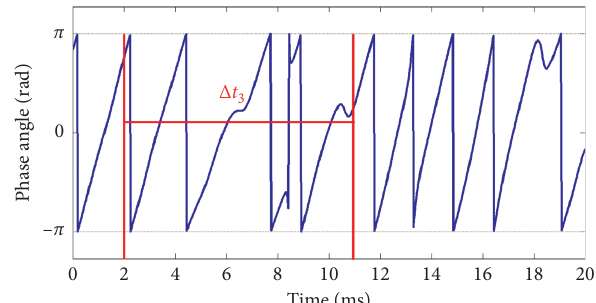
Figure 16: Time-phase angle curve with the frequency of